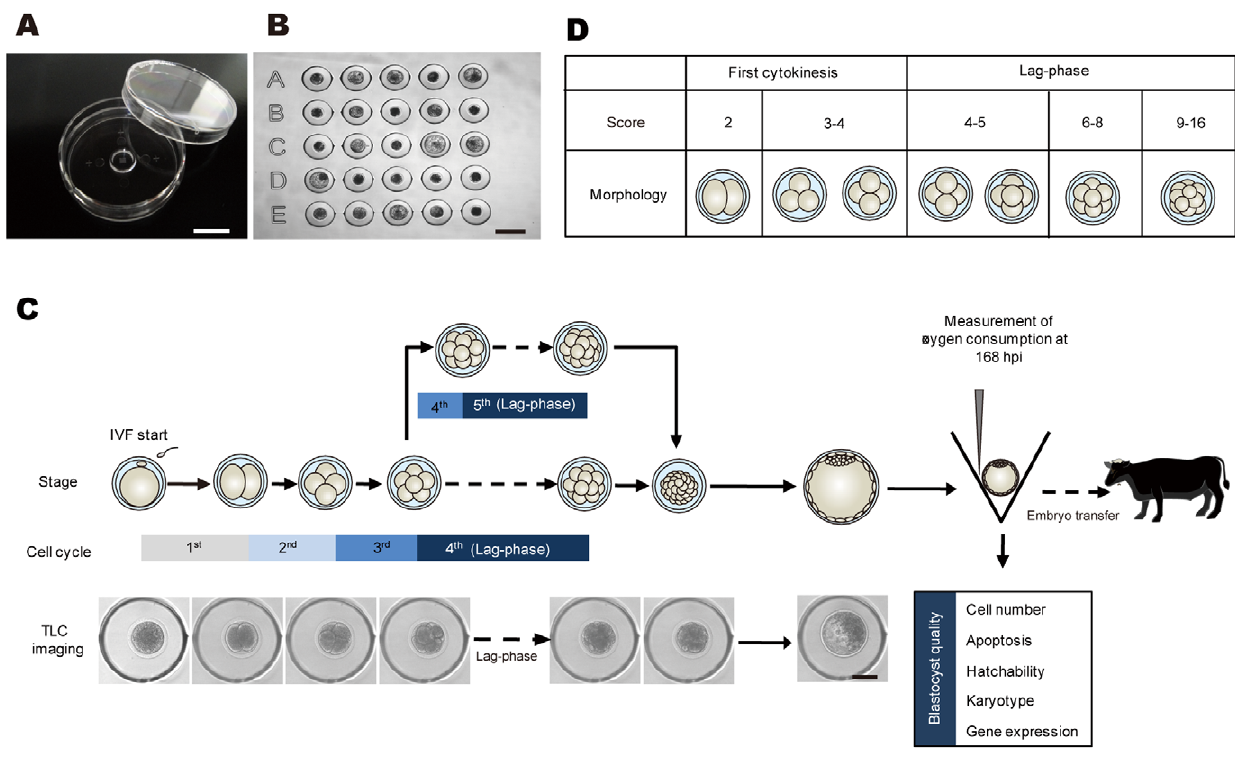
Figure 1. Overview of the experimental scheme. In vitro development of bovine IVF embryos in the developed microwell culture dish with identification code ( A and B ) was tracked with time-lapse cinematography (TLC) for 168 h post-insemination (hpi). SECM was used to measure oxygen consumption in embryos that developed to the blastocyst stage at 168 hpi ( C ). Timing of the of the first cleavage; duration of the second, third, and lag-phases resulting in developmental arrest at the fourth or fifth cell cycle; number of blastomeres; presence or absence of multiple fragments; unevenness or evenness of division at the end of the first cleavage and at the onset of the lag-phase; cell cycle observed lag-phase (fourth or fifth cell cycle); and oxygen consumption at 168 hpi were examined in relation to blastocyst qualities such as cell number (n=173), apoptosis incidence (n=74), hatchability (n=195), karyotype (n=111), and gene expression (n=75) with multivariate analysis. Based on the identified prognostic factors that reflected the various blastocyst qualities, OPU-IVF blastocysts (n=52) were then assessed and transferred to recipient cows (n=52). ( D ) The number of blastomeres at the end of the first cleavage was categorized as 2 and 3/4 blastomeres. The numbers of blastomeres at the onset of the lag-phase were categorized as 4/5, 6–8, and 9–16 based on the result from Fig. S1. Bar=10 mm ( A ), 300 m m ( B ) and 100 m m ( C